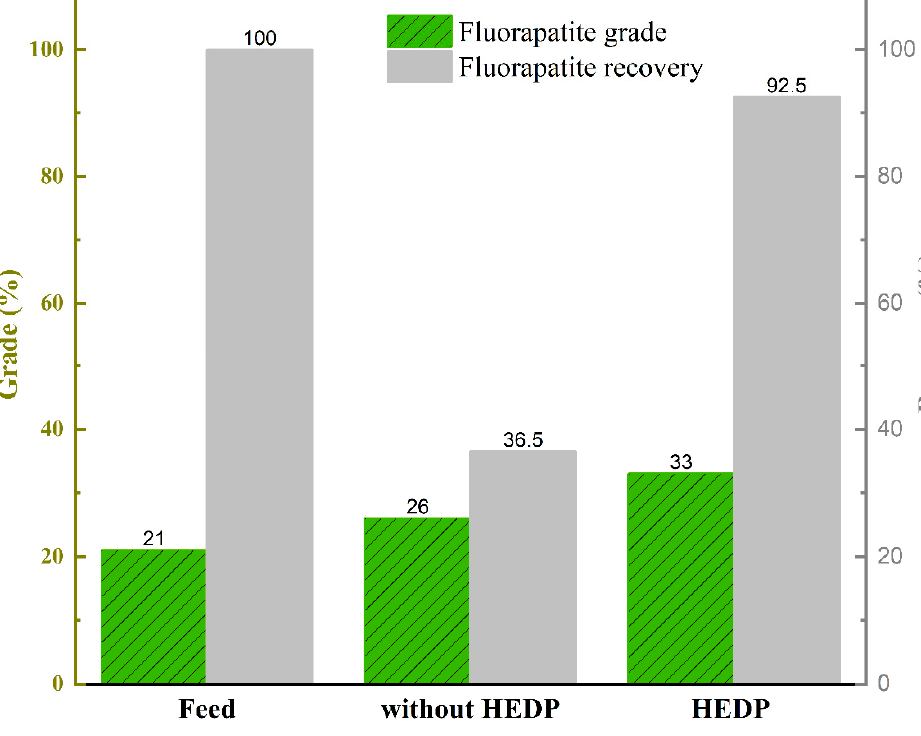
Figure 6. Phosphorus concentrates grade and recovery under the reaction of various reagents in artificial mixed-mineral experiments. artificial mixed-mineral